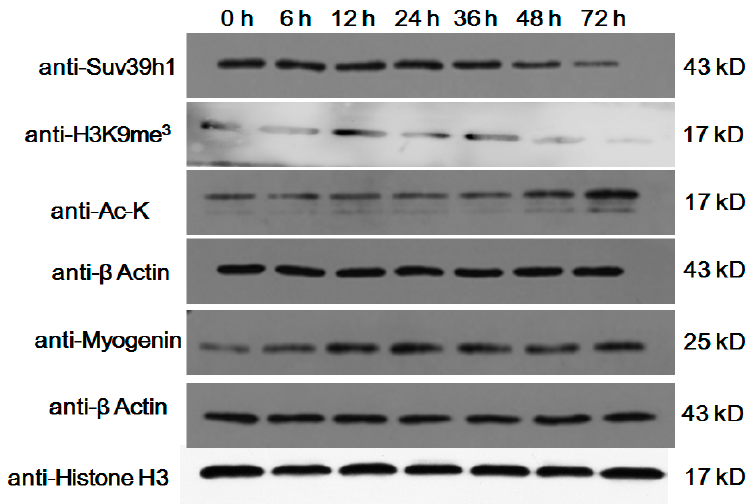
Figure 1. Expression of Suv39h1 during myoblast differentiation. C2C12 cells were cultured in differentiation medium for 0, 6, 12, 24, 36, 48 and 72 h. Western blot analyses were performed with cell extracts using antibodies that recognized the indicated proteins. β -actin and histone H3 were used as a loading control.